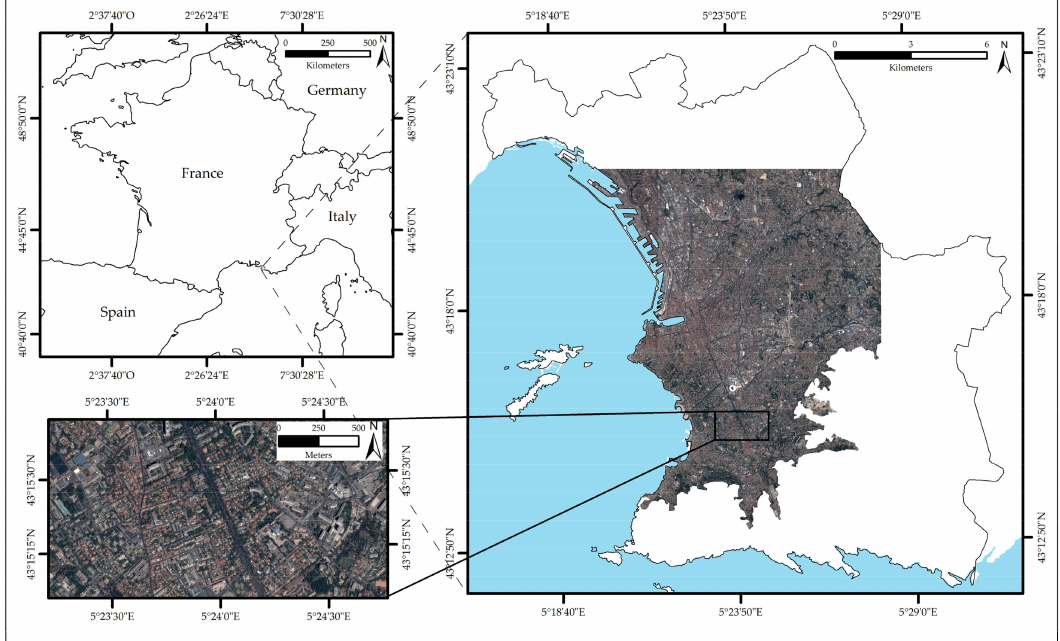
Figure 1. Location of the study area within the city of Marseille (right) in France (upper left) and zoom over the study area (lower